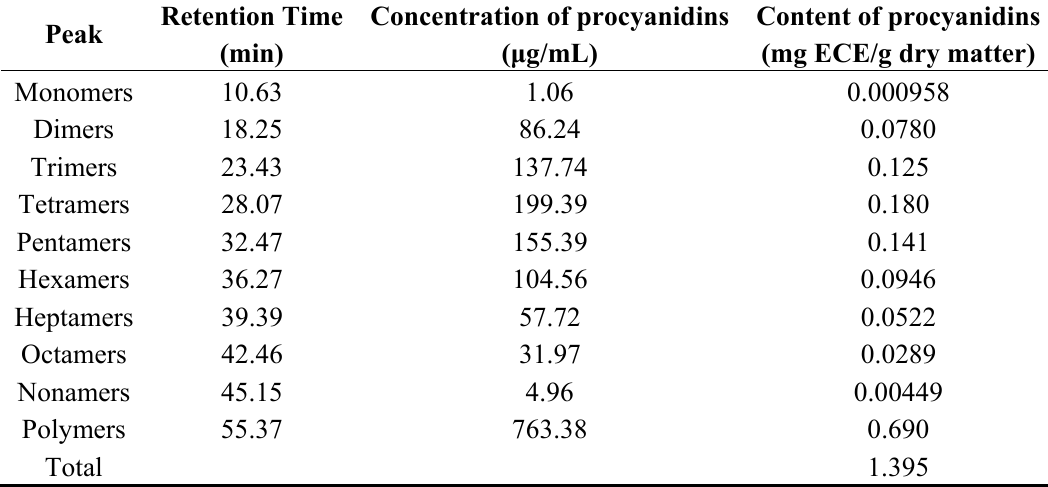
Table 1. Oligomeric proanthocyanidin profiles in durian seeds (unit: mg/g dried seeds).